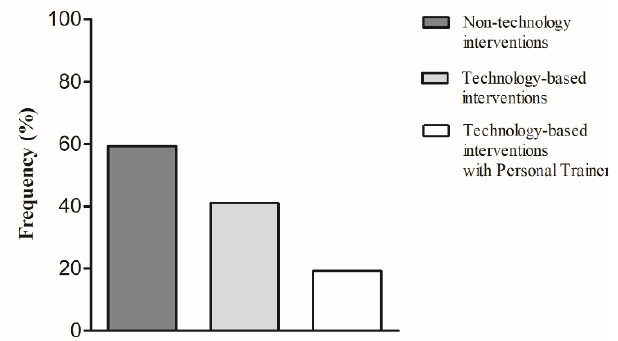
Figure 2. Proportion of self-reported physical activity modality of women before and during COVID-19 home confinement.